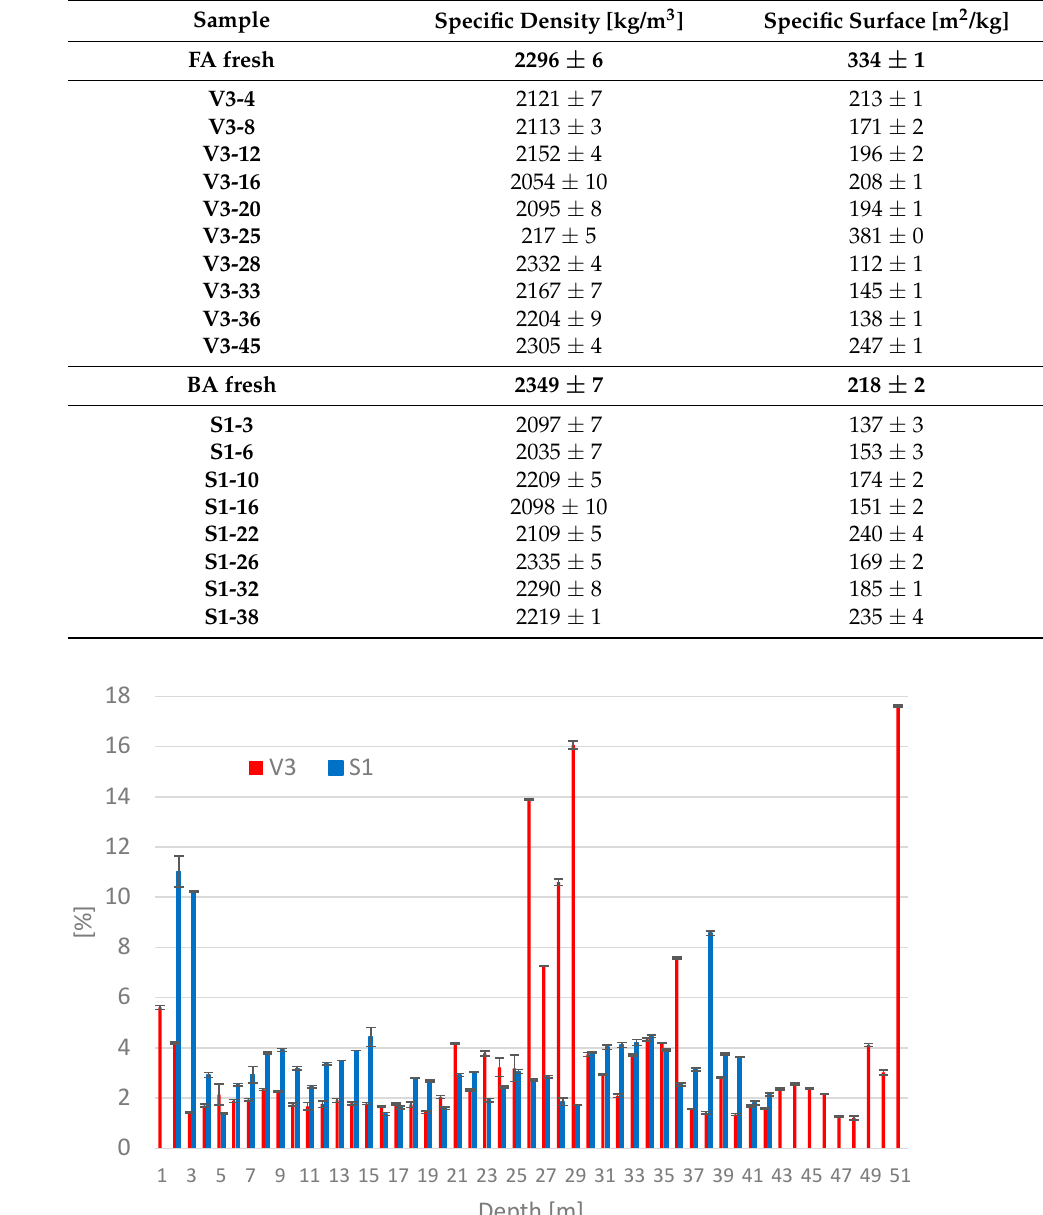
Figure 4. Determination of Loss on Ignition from Core Boreholes V3 and S1.